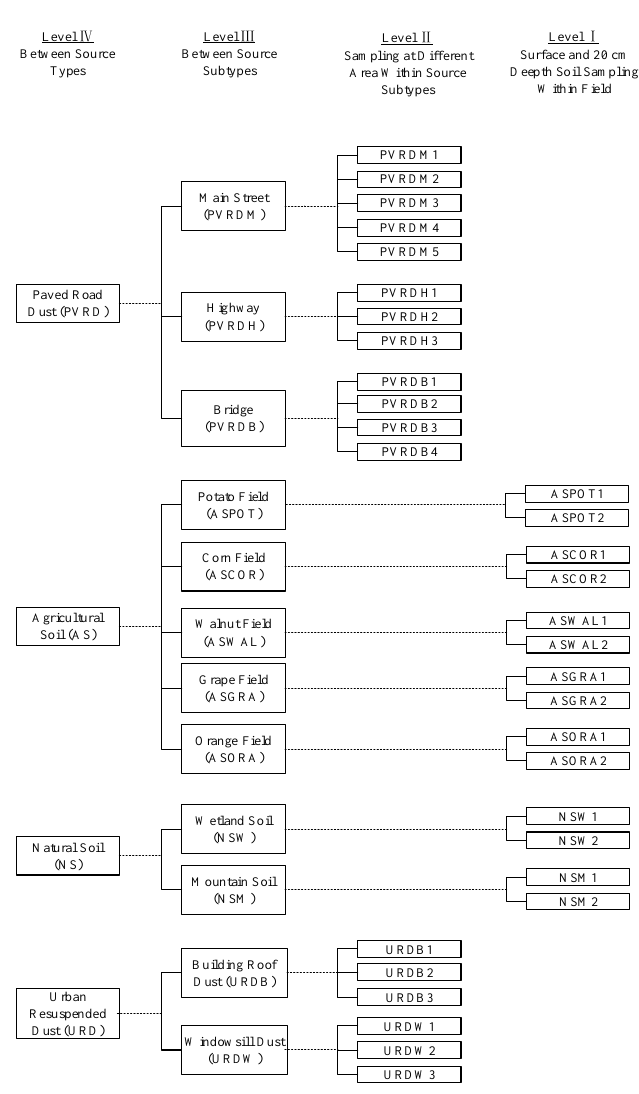
Figure 1. Source profile-compositing scheme for testing within-source and between-source variability. Source profile abbreviations for each level are given in parentheses.